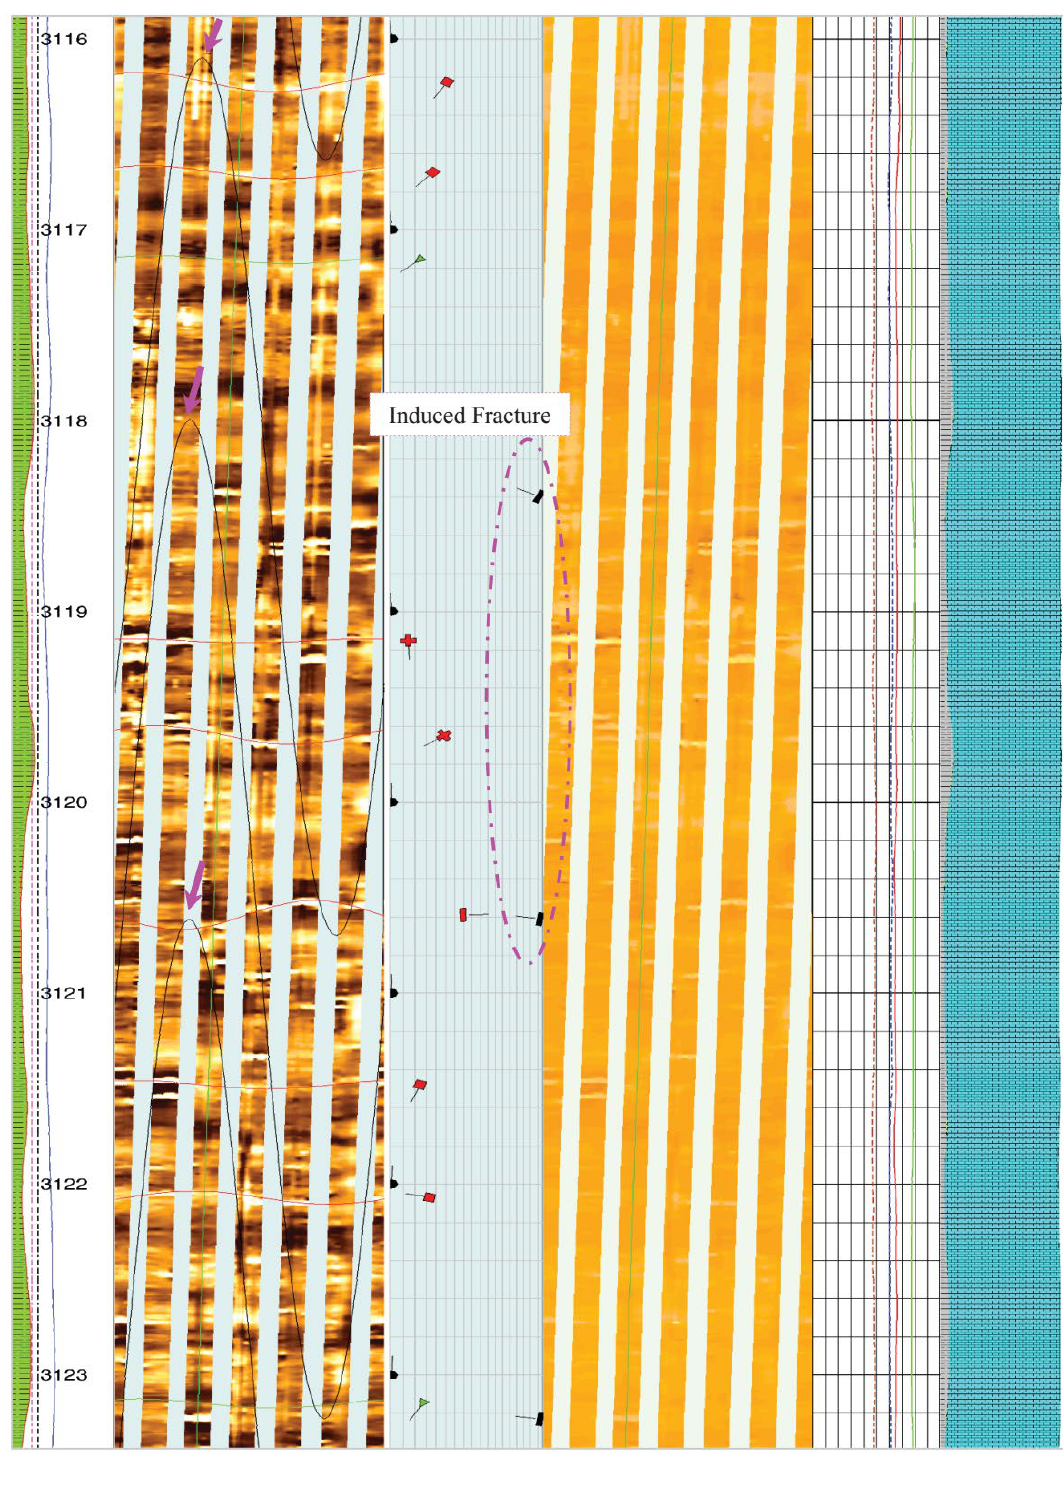
Figure 4. The image log, the induced fractures show the direction of the maximum horizontal stress to be mainly “N60E”. Since no image logs were available for the interested depths across reservoir-B for hydraulic fracturing, it was assumed that the stress directions can be extrapolated downhole to the formation.